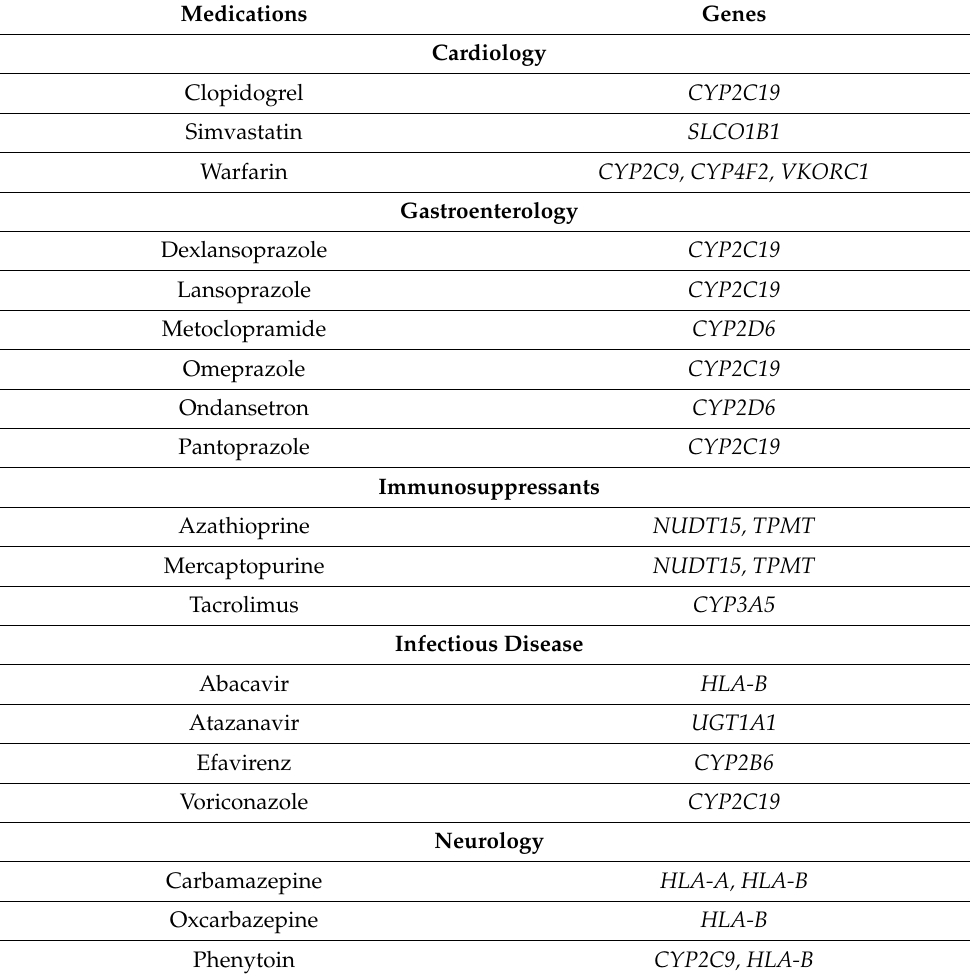
Table 1. Examples of drugs and associated genes with actionable prescribing recommendations from the Clinical Pharmacogenetics Implementation Consortium guidelines and/or U.S. Food and Drug Administration-approved drug